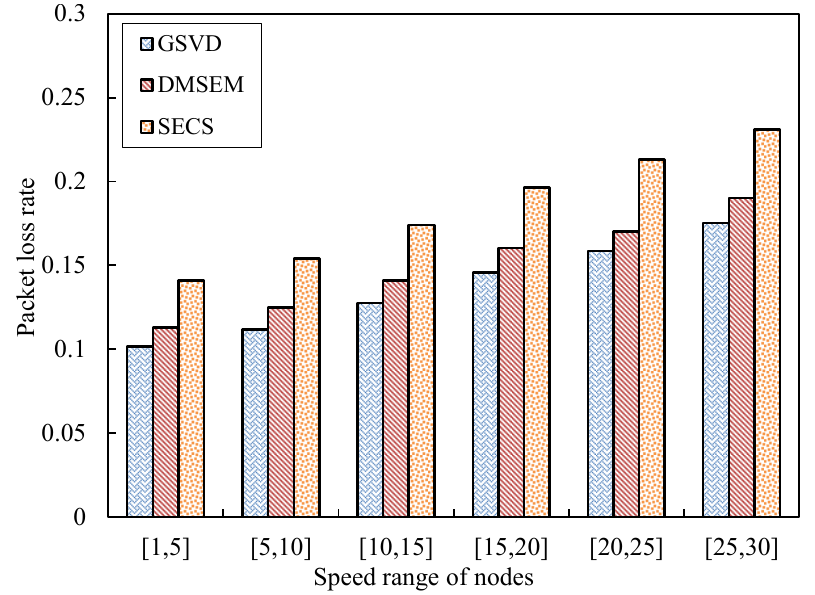
Figure 8. Packet loss rate against various speed ranges of nodes. GSVD makes use of the code-based geographical location to calculate the